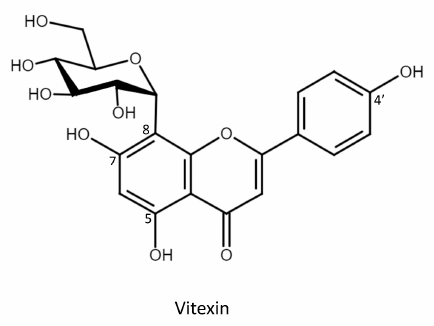
Figure 1. Chemical structure of vitexin.